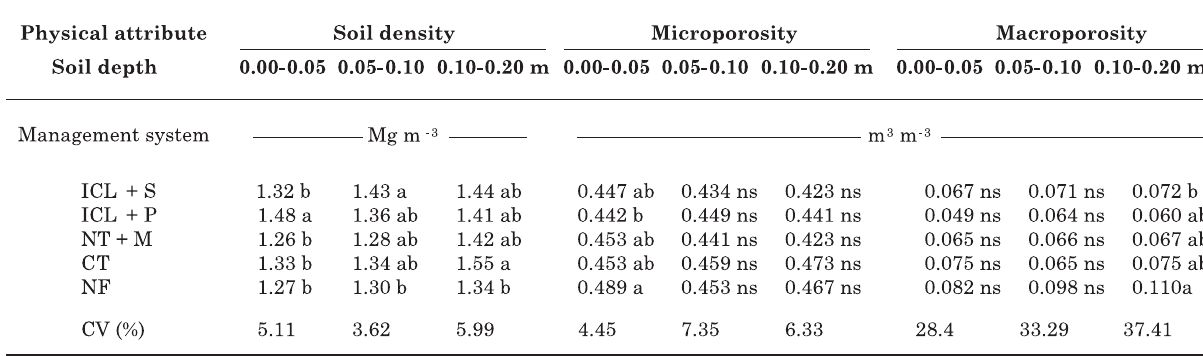
Table 2. Soil density, macroporosity and microporosity of Yellow Latosol at depths 0.00–0.05, 0.05–0.10